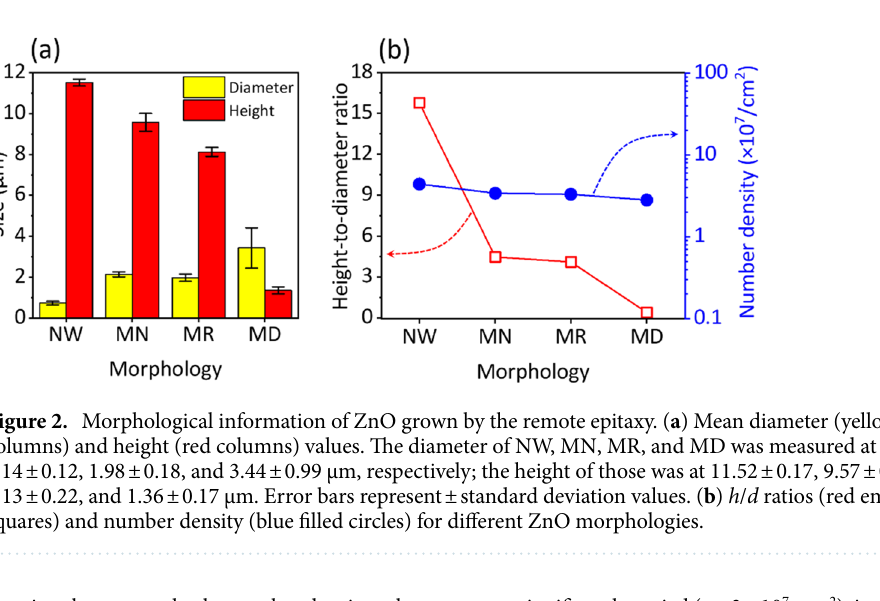
ZnO morphology (blue solid circles of Fig. 2b). As the concentration of equimolar nutrient solution was diluted, the size and density of microcrystals were reduced without morphology variations (Fig. S2). Accordingly, the